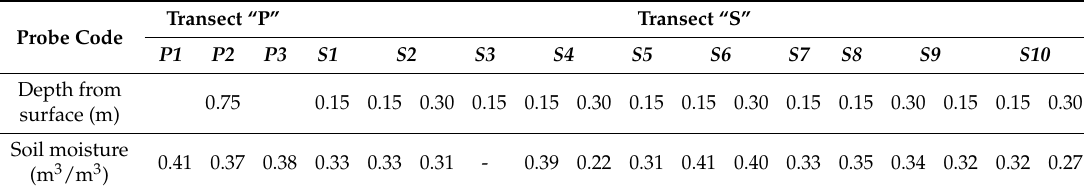
(in agreement with the expected values).